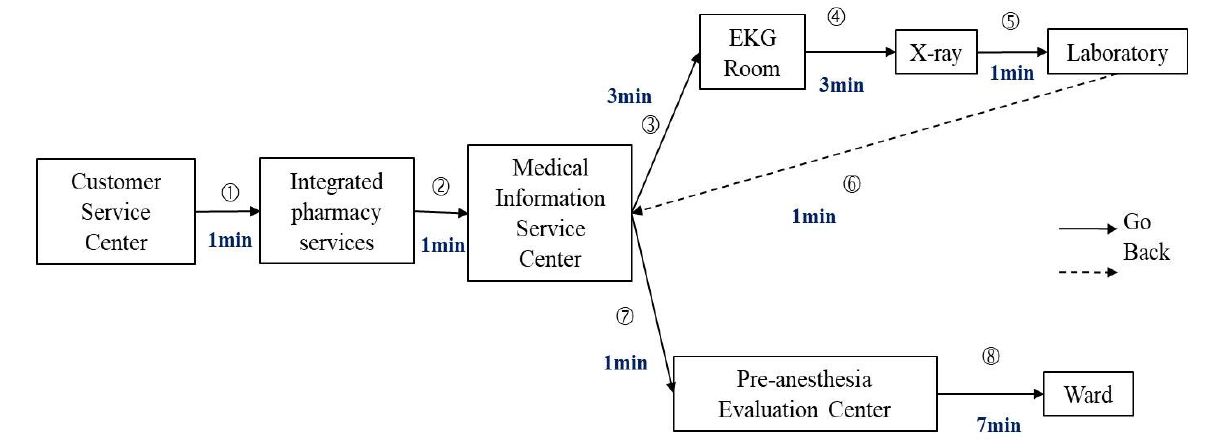
Figure 5. After the integration of the facility’s hospitalization procedure.